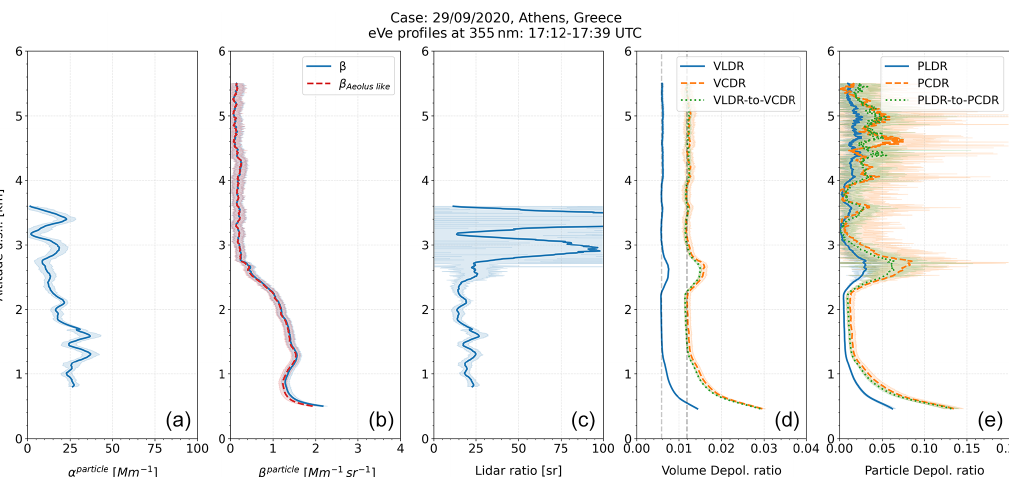
Figure 9. Profiles of the particle extinction coefficient, the particle backscatter coefficient, the lidar ratio, the volume depolarisation ratios and the particle depolarisation ratios (from left to right) at 355nm for the time frame 17:12 to 17:39UTC on 29 September 2020. The Aeolus-like particle backscatter coefficient ( β Aeolus-like ; dashed red line) and the particle backscatter coefficient ( β ; solid blue line) were both retrieved from the circularly polarised signals of eVe lidar using the Raman inversion method, where the reference height for Rayleigh atmosphere was selected at 10.3km with a 0.3km window. The VLDR and PLDR profiles are presented by solid blue lines, and the VCDR and PCDR profiles are presented by dashed orange lines, while the VLDR-to-VCDR and PLDR-to-PCDR profiles are presented by dotted green lines. The corresponding mLDR and mCDR values (dashed grey lines) that are expected to be measured by the lidar are also provided in the volume depolarisation ratio subplot. Shaded regions denote statistical 1 σ uncertainty.